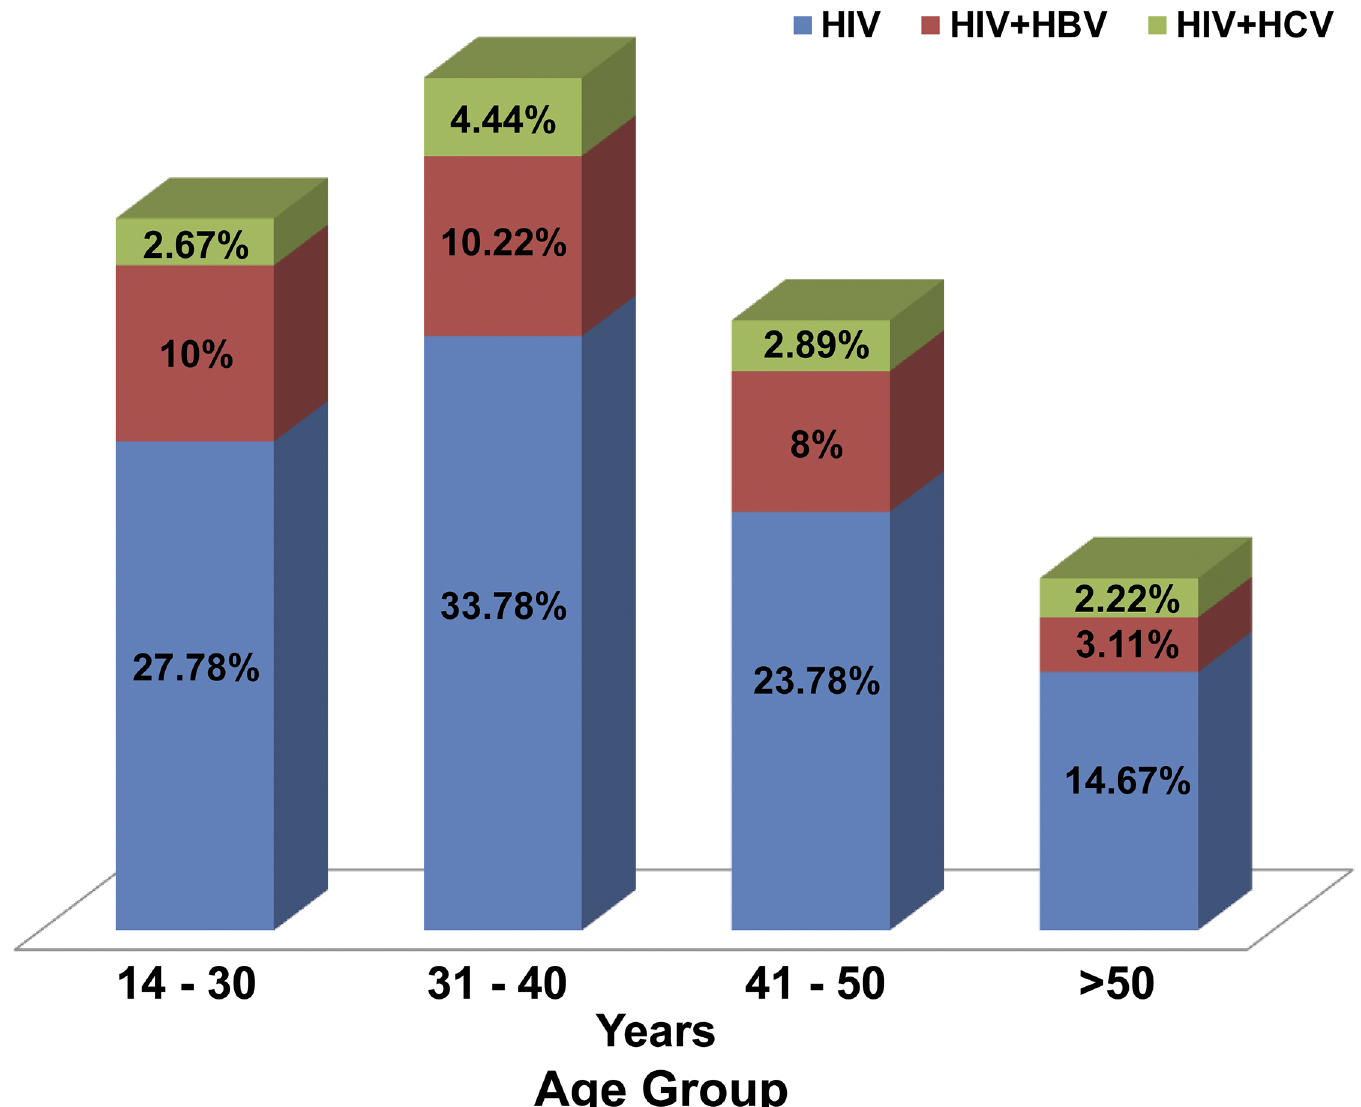
Fig 2. Age-specific prevalence for co-infection with HBV or HCV. Prevalence rates were calculated based on the proportion of study participants at risk of co-infection in a given age